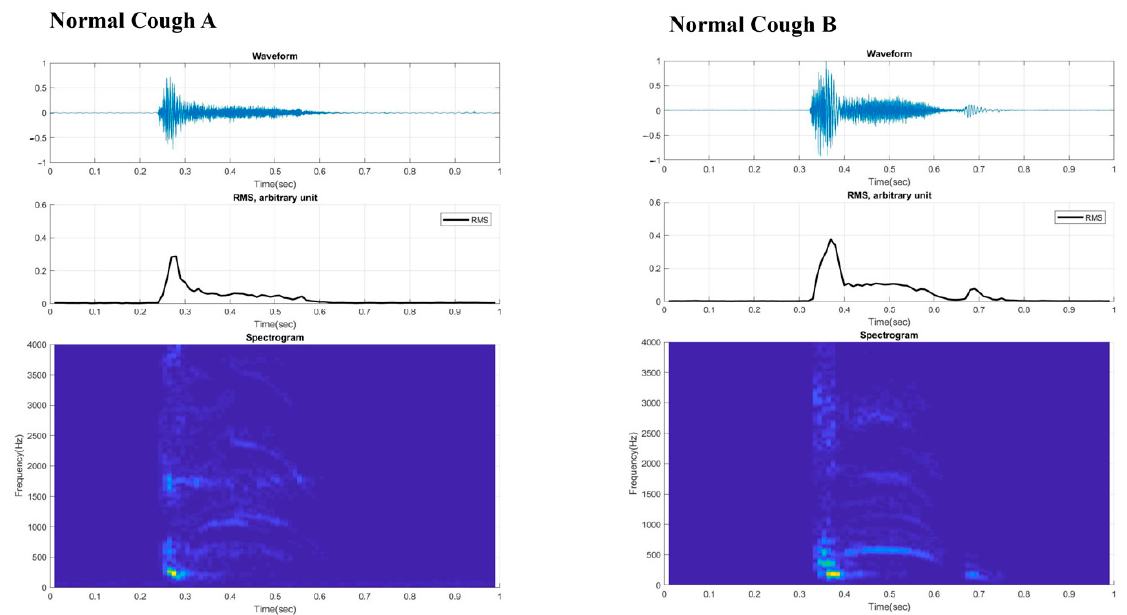
Figure 4. Digital cough sounds from Case 2 are presented for the three times, represented by several values (times) col- lected on different dates. From top to bottom, waveform, root mean square, and spectrogram data of the cough sounds are shown with cough ( A ) at baseline, ( B ) at follow-up but still with poor cough and cough ( C ) at improvement.